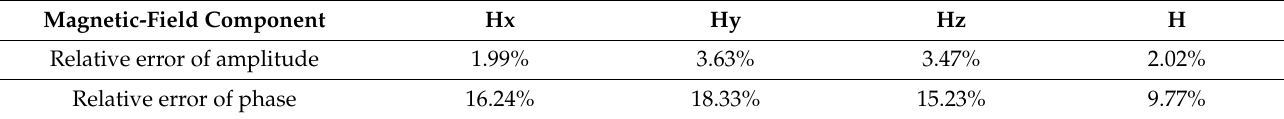
Table 4. Relative errors of magnetic field obtained by method of this article.